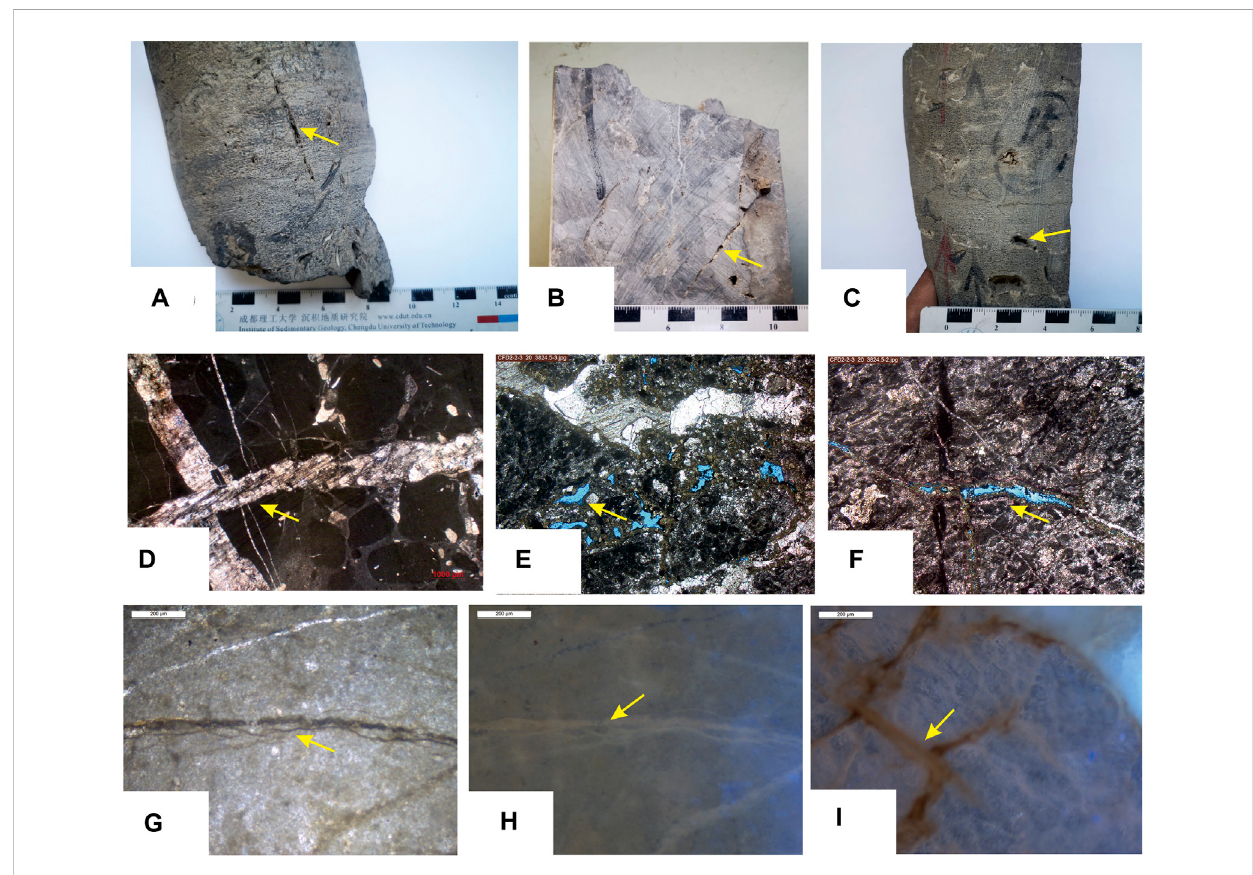
FIGURE 2 (A) :Fractures incores; (B) Fractures with dissolved pore in cores; (C) Fractures with dissolved holes in cores; (D) Fractures in thinsection, noting the cutting of two set of fractures; (E) Fractures in thin section, noting the corrosion along fractures; (F) Fractures in thin section, noting the corrosion in fractures; (G) Fracturesinthinsection,Asphalt fi llinginsidefractures; (H) Fracturesinthinsection,notingthe fl uorescenceinthefracture,whichindicating that the fracture is an important migration channel; (I) Network fractures in thin sections fi lled with